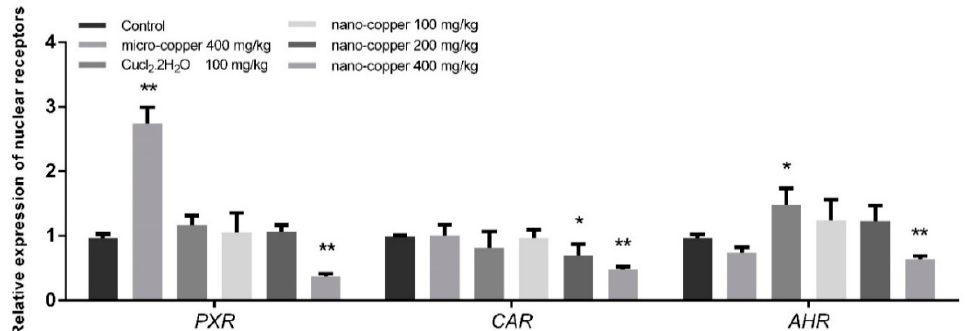
Figure 6. The mRNA levels of nuclear receptors in rat livers. * p < 0.05, ** p < 0.01 vs. control group. Nano-copper decreased the expression of PXR , AHR and CAR , but Micro-copper and CuCl 2 increased the level of PXR and AHR , respectively.